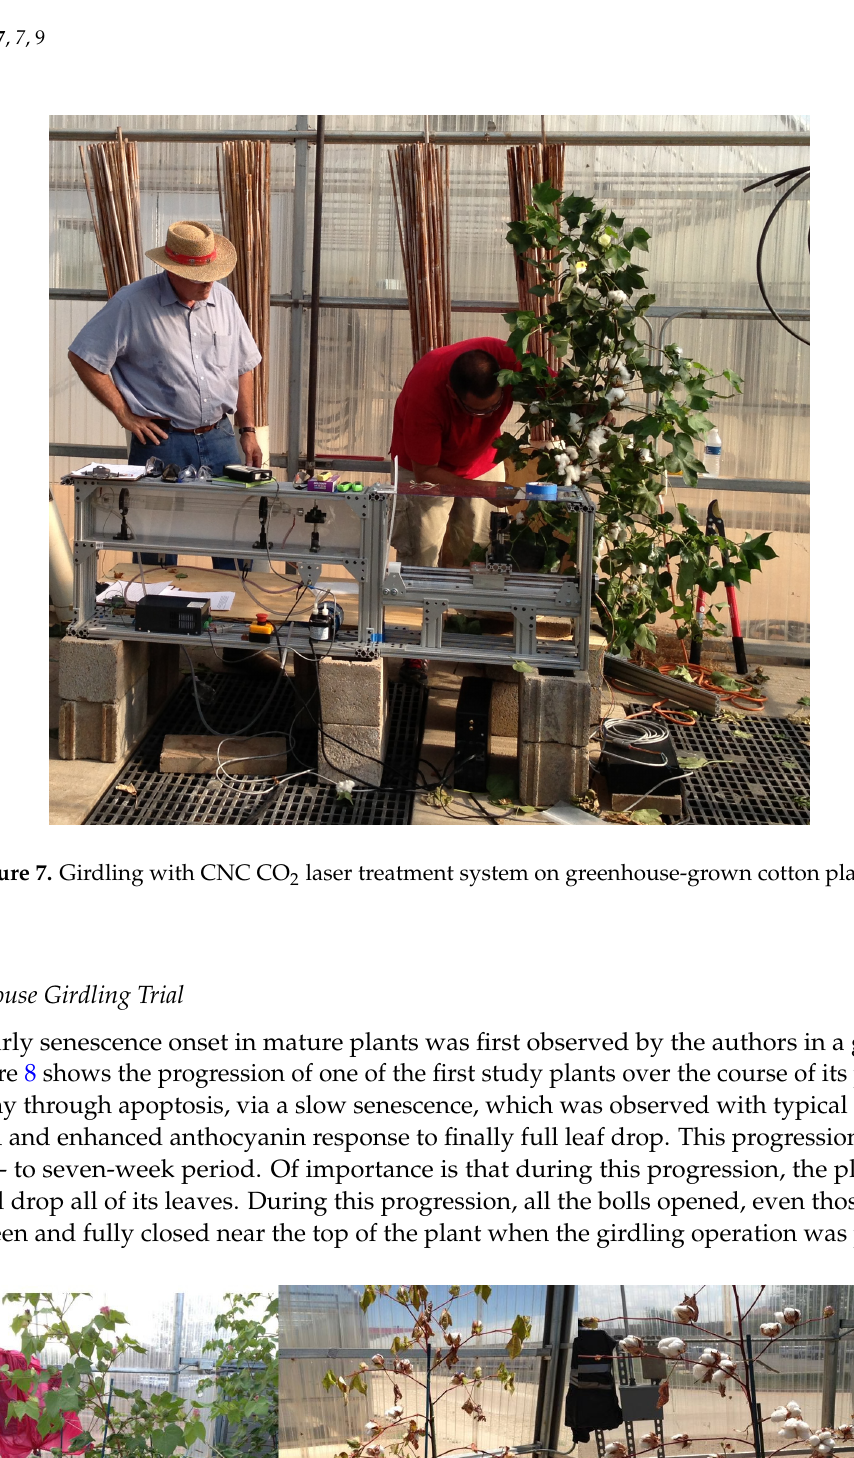
Figure 9. Defoliation efficacy for greenhouse ‐ grown plants utilizing small 4 L pots for replicated comparison of (control, hand ‐ girdled, laser ‐ girdled).